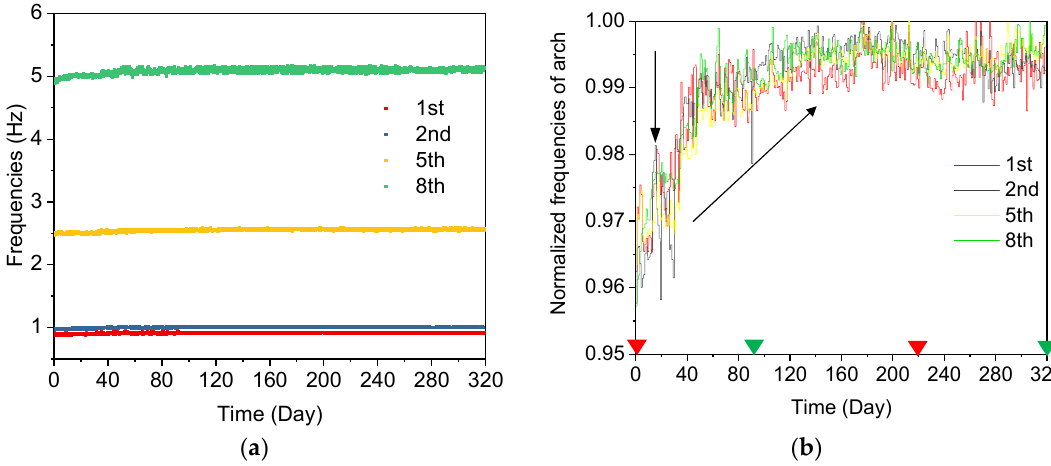
Figure 14. Frequencies of the lateral arch and vertical deck from 1 March 2017 to 31 July 2018: ( a ) the long-term frequencies of the modes dominated by the arch; ( b ) the average normalized frequencies of the modes dominated by the arch. (The two triangle marks in green: the 90th day (15 August 2017) and the 320th day (31 July 2018); The two triangle marks in red: the 1st day (1 March 2017) and the 220th day (1 March 2018)).